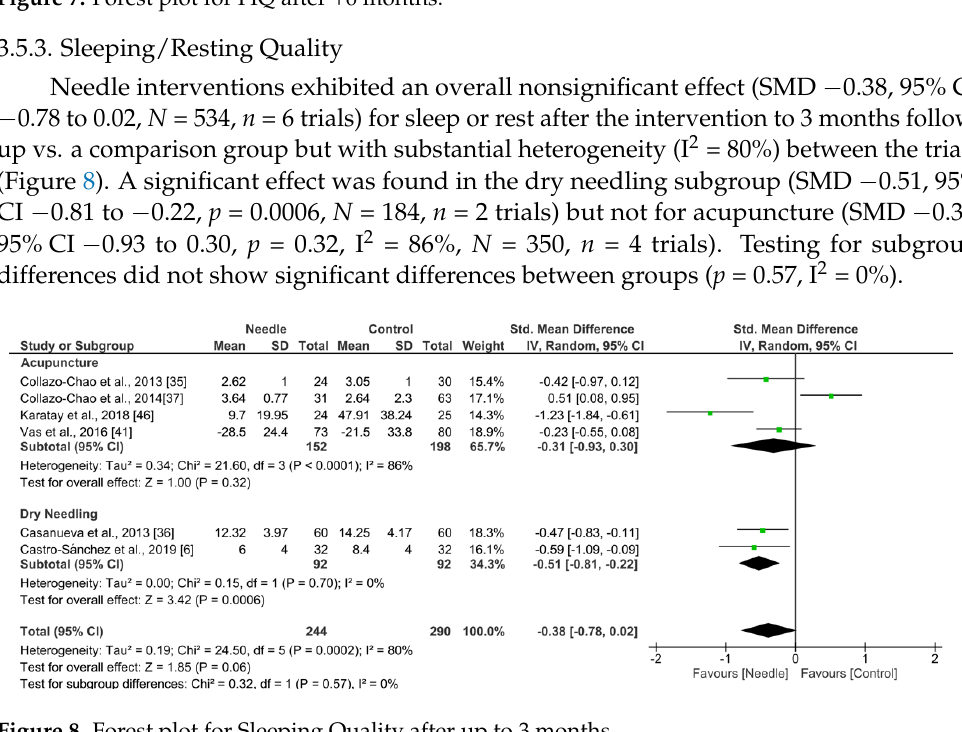
Figure 7. Forest plot for FIQ after +6 months.